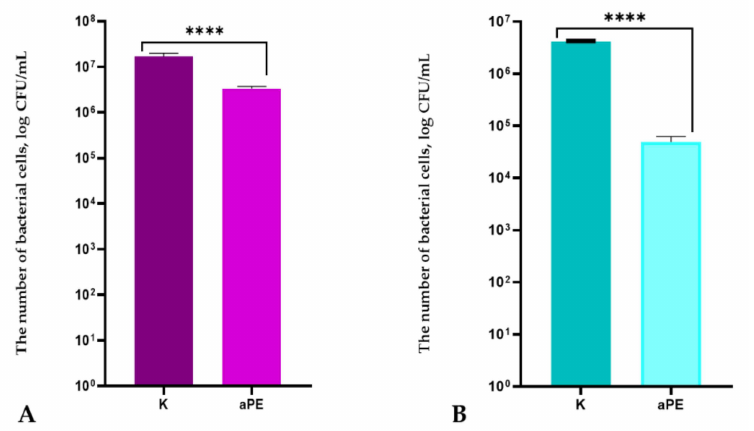
Figure 3. The influence of active polyethylene film on Gram-negative bacteria growth A : E . coli ; B : P. syringae . K—PE film; aPE—PE film containing a mixture of CO 2 extracts of raspberry seeds, pomegranate seeds, and rosemary in polymer matrix; unpaired t -test: ****— p <